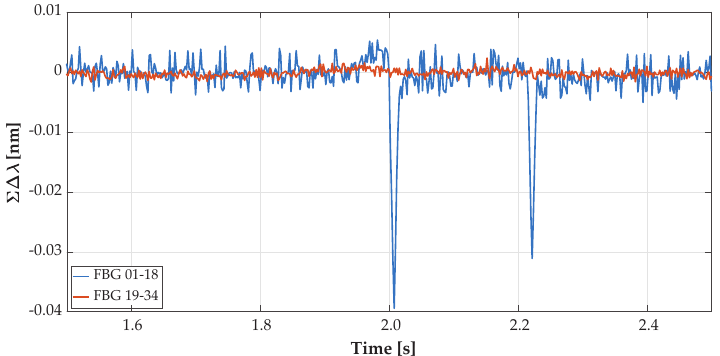
Figure 11. Record details of the summed wavelength shifts (of the reflected optical spectrum) from the vertical FBG sensors of the overpassing vehicle recognized only by the left